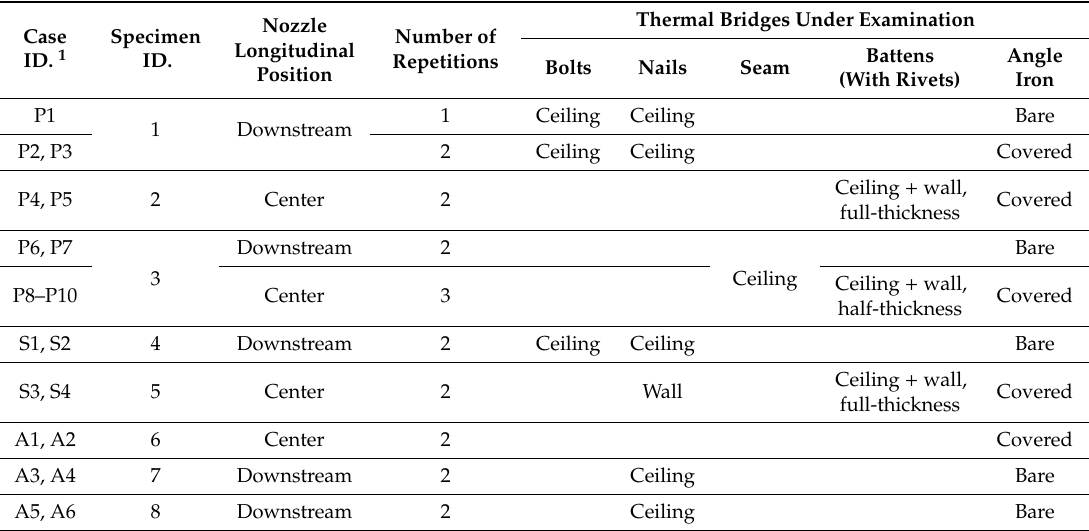
Table 2. Overall testing design and thermal bridges of